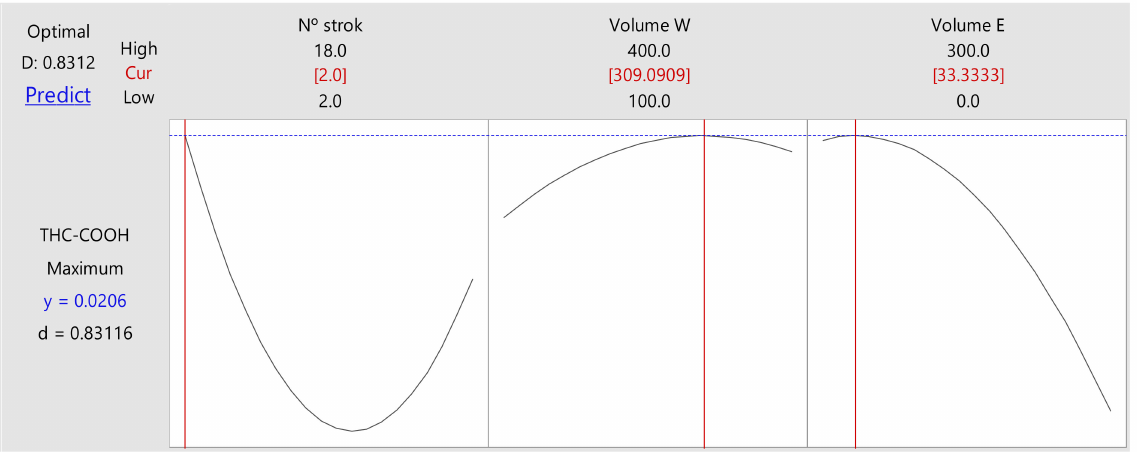
Figure 2. Results from RSM response optimizer for THC-COOH. N 0 strok: number of strokes; Volume W: washing volume; Volume E: elution